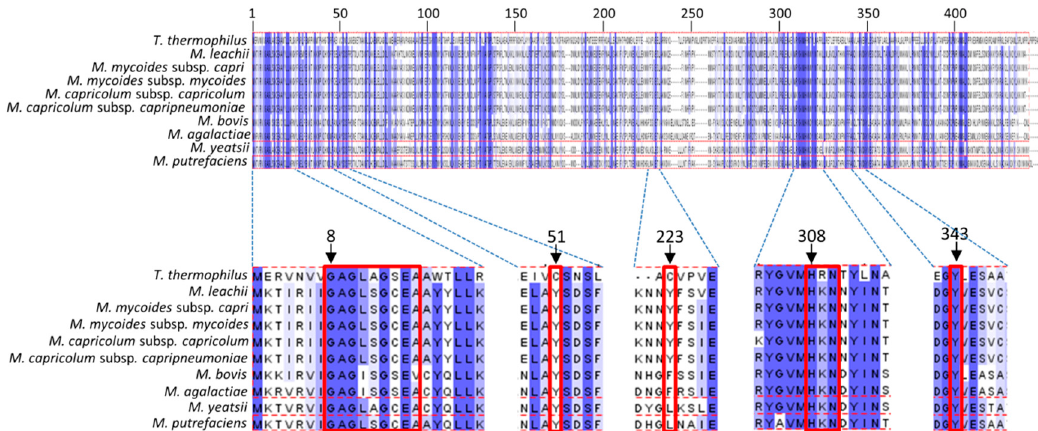
Figure 5. Conserved positions in TrmFO-like homologs. Multiple alignment of TrmFO-like proteins with reference TrmFO from T. thermophilus was implemented into Jalview to get an overview of the conserved positions. Amino acids conserved at > 50% are indicated in blue. Important regions described in the main text are enlarged below the overview alignment. Positions indicated by arrows correspond to numbering in the reference TrmFO protein of T. thermophilus.